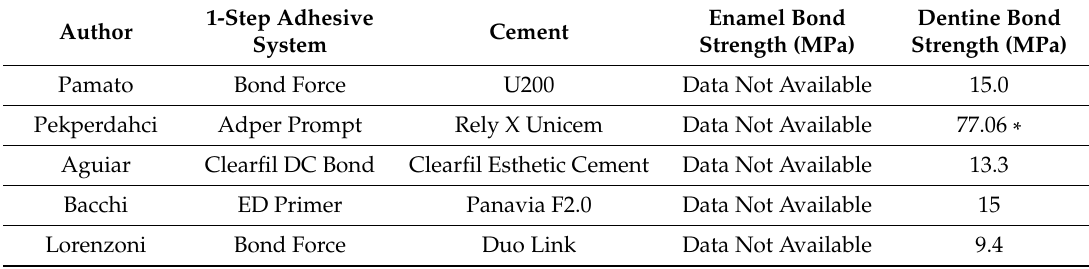
Table 4. Bond strength of 1-step self-etch adhesive systems.